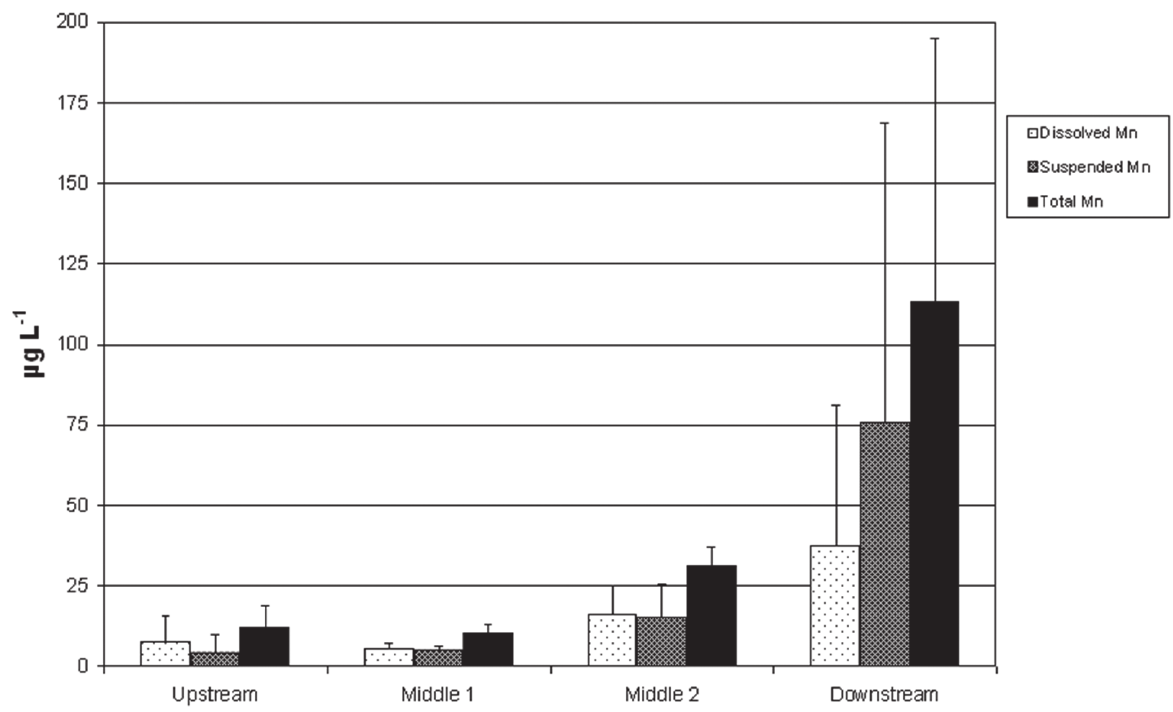
Figure 3 - Average and standard deviation of dissolved, suspended and total Mn in the Pardinho